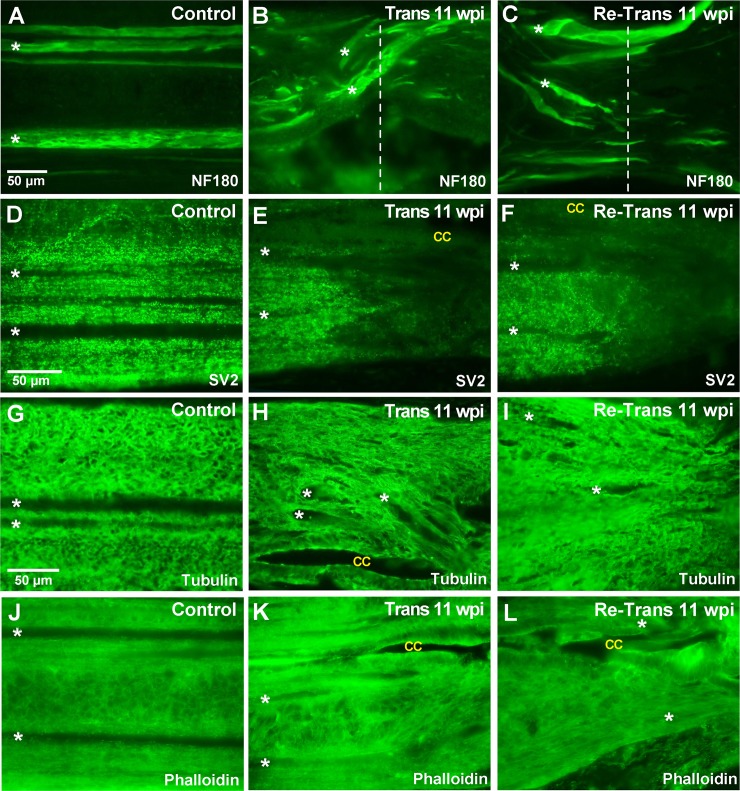
Cellular distribution of axons, synapses, and cytoskeleton are also similar at 11 wpi after spinal transection and re-transection.(A-C) NF-180 staining of large and medium caliber axons in the control, transected and re-transected spinal cords. Note the aberrant axonal growth patterns after spinal injury. Dotted lines indicate lesion center and show a number of regenerating axons. Scale bar in A applies to all panels except D and G. Asterisks indicate several large RS axons here and in all subsequent panels. (D-F) SV2 staining shows punctate labeling of synapses in all conditions. Note the tapering signal at the rostral-lesion border in the transected and re-transected spinal cords. CC = central canal. (G-I) Tubulin staining labels microtubule-rich processes throughout the neuropil. There are no major differences after spinal re-transection. (J-L) Phalloidin staining labels F-actin and appears as a diffuse signal surrounding axons and cell bodies in the spinal cord. Rostral is to the left in all images.